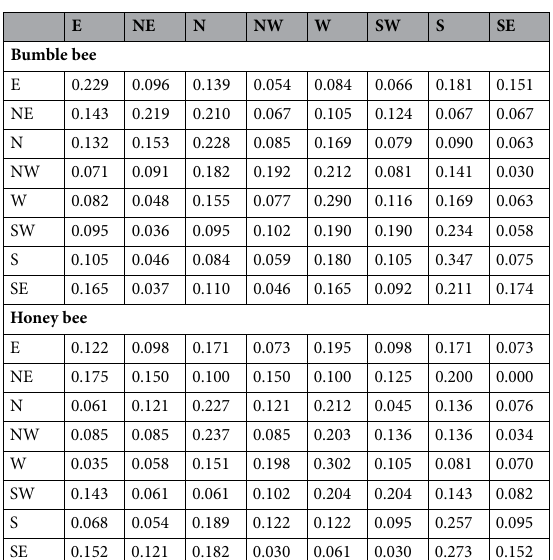
The second year, bee species was statistically significant, and we found a model for each bee species. The model for bumble bees was log e distance = 3.04 − 0.28 log e flower number, with a statistically significant random foraging bout effect (Table 3). The negative relationship between log e distance and log e flower number was maintained in the honey bee model but the random foraging bout effect was not statistically significant (Table 3). For leafcutting bees, only the intercept was statistically significant in the model (Table 3). We also considered combining years and determined that a better model fit and higher precision was obtained by examining each year separately. Transition matrix or vector for directions traveled between consecutive racemes. The transi- tion probability matrices calculated from field data are presented in Table 4 for bumble bees and honey bees. The transition vectors for the three bee species are presented in Table 5. For bumble bees and honey bees, the highest frequency was associated with remaining in the same direction (0° angle), which supports the directionality of movement within foraging bouts for these two bee species. Model that best described bee movement for each bee species. For bumble bees, the “Modeled Distance-Modeled Direction” model was not rejected (higher probability values), whether each year was con- sidered separately, or data from both years were combined. In contrast, the “Random Distance-Random Direc-